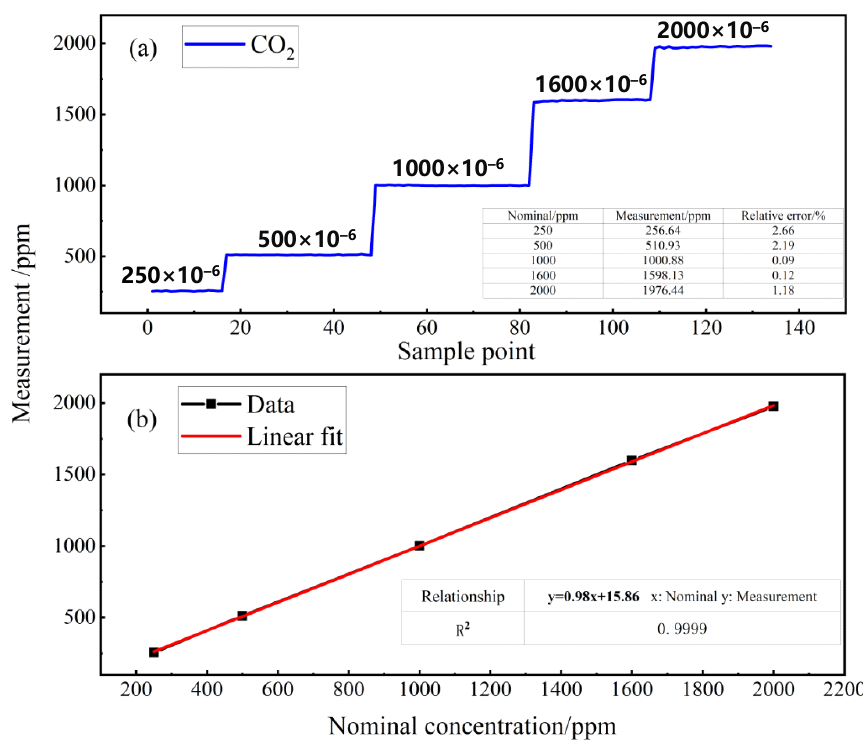
Figure 7. ( a ) Measured results of CO 2 samples ranging from 250 ppm to 2000 ppm and ( b ) a linear fit to the measured data.